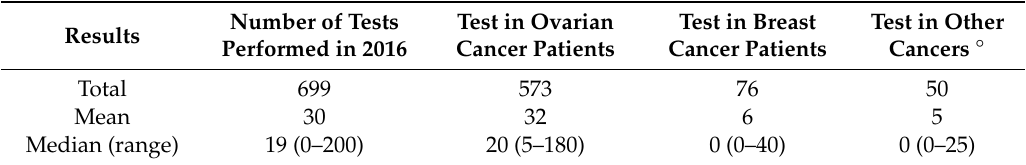
Table 3. Somatic BRCA1 / 2 test performed in 2016 in di ff erent cancer